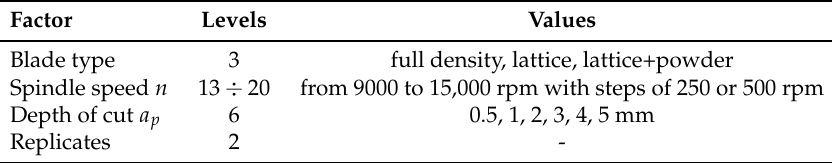
Table 3. Design of experiments for the final chatter tests.